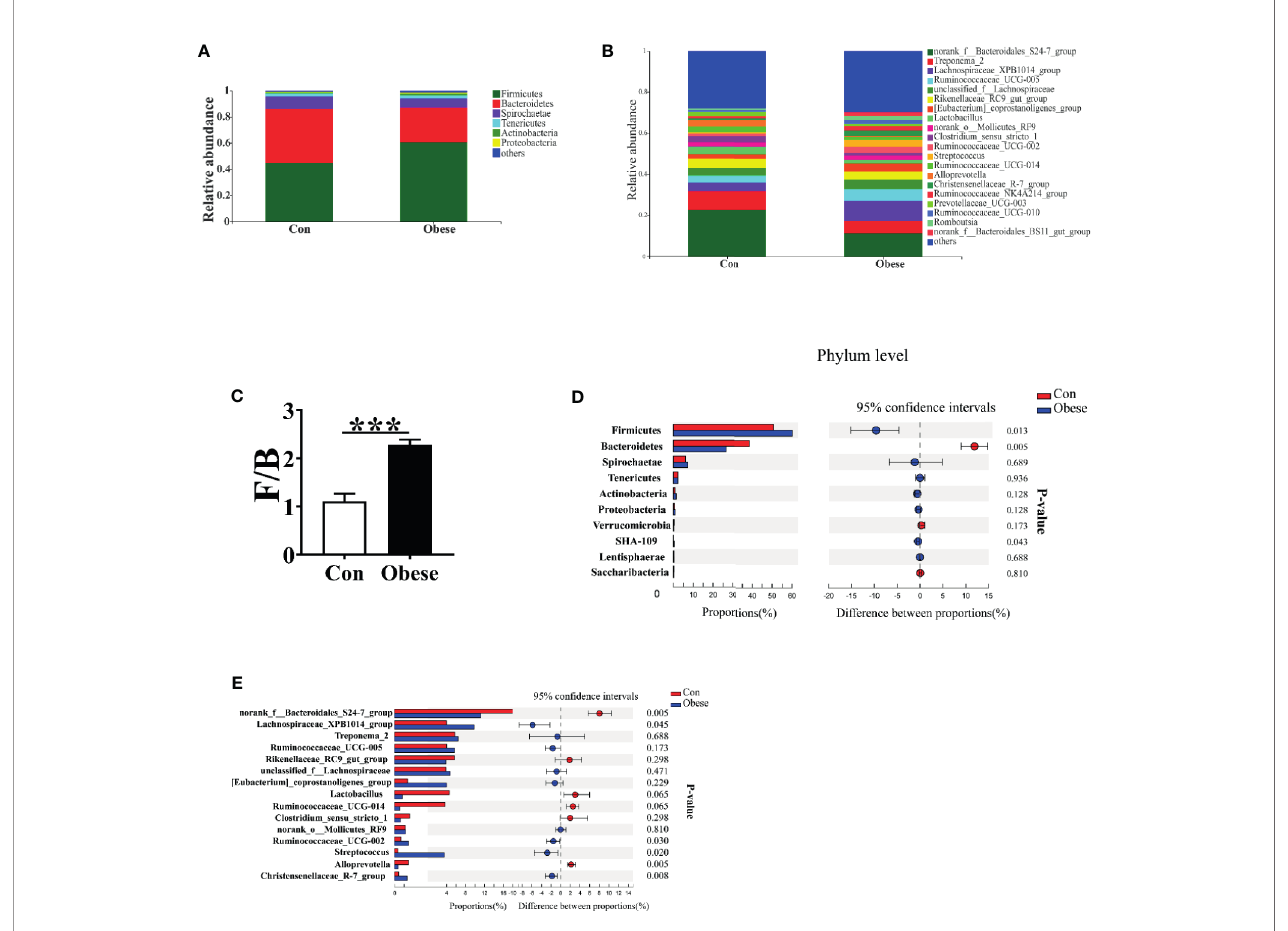
FIGURE 7 | Microbial community composition. Distribution of microbiota composition at phylum (A) and genera levels (B) . (C) The ratio of Firmicutes to Bacteroidetes (F: B). Comparison of relative abundance at the phylum (D) and genus (E) levels between the two